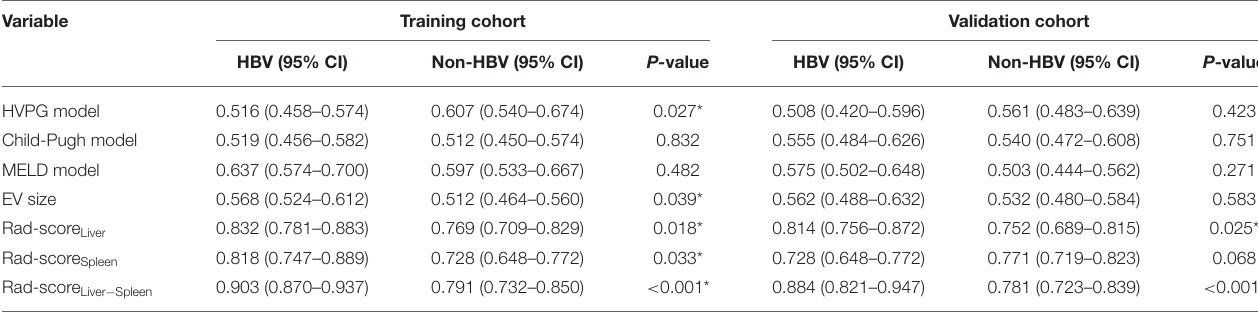
TABLE 5 | Subgroup analysis of the C-indexes of the HBV and non-HBV